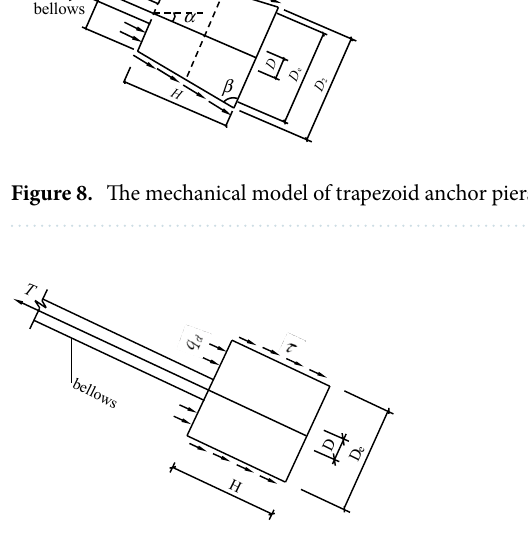
Figure 9. The mechanical model of equivalent rectangular anchor